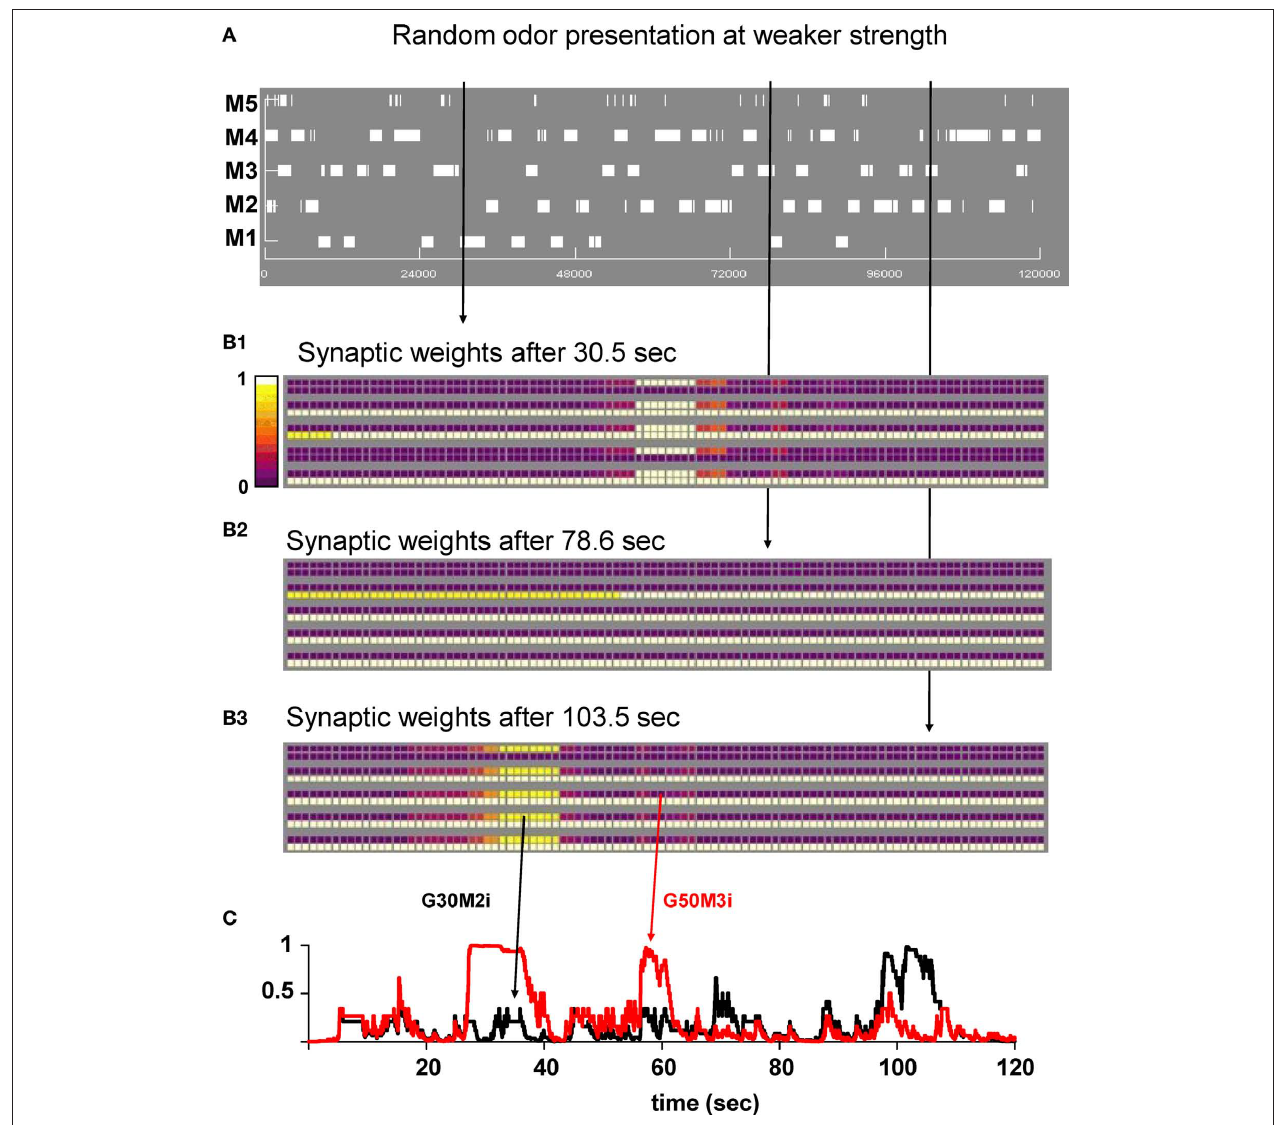
FIgure 4 | random presentation of odors at lower strengths reveals dynamic cluster formation. (A) Mitral cell raster plot during a 120-s simulation. Odors were presented in a random sequence of 2 s frames. (B1–B3) Snapshots of the synaptic weights at different times during the